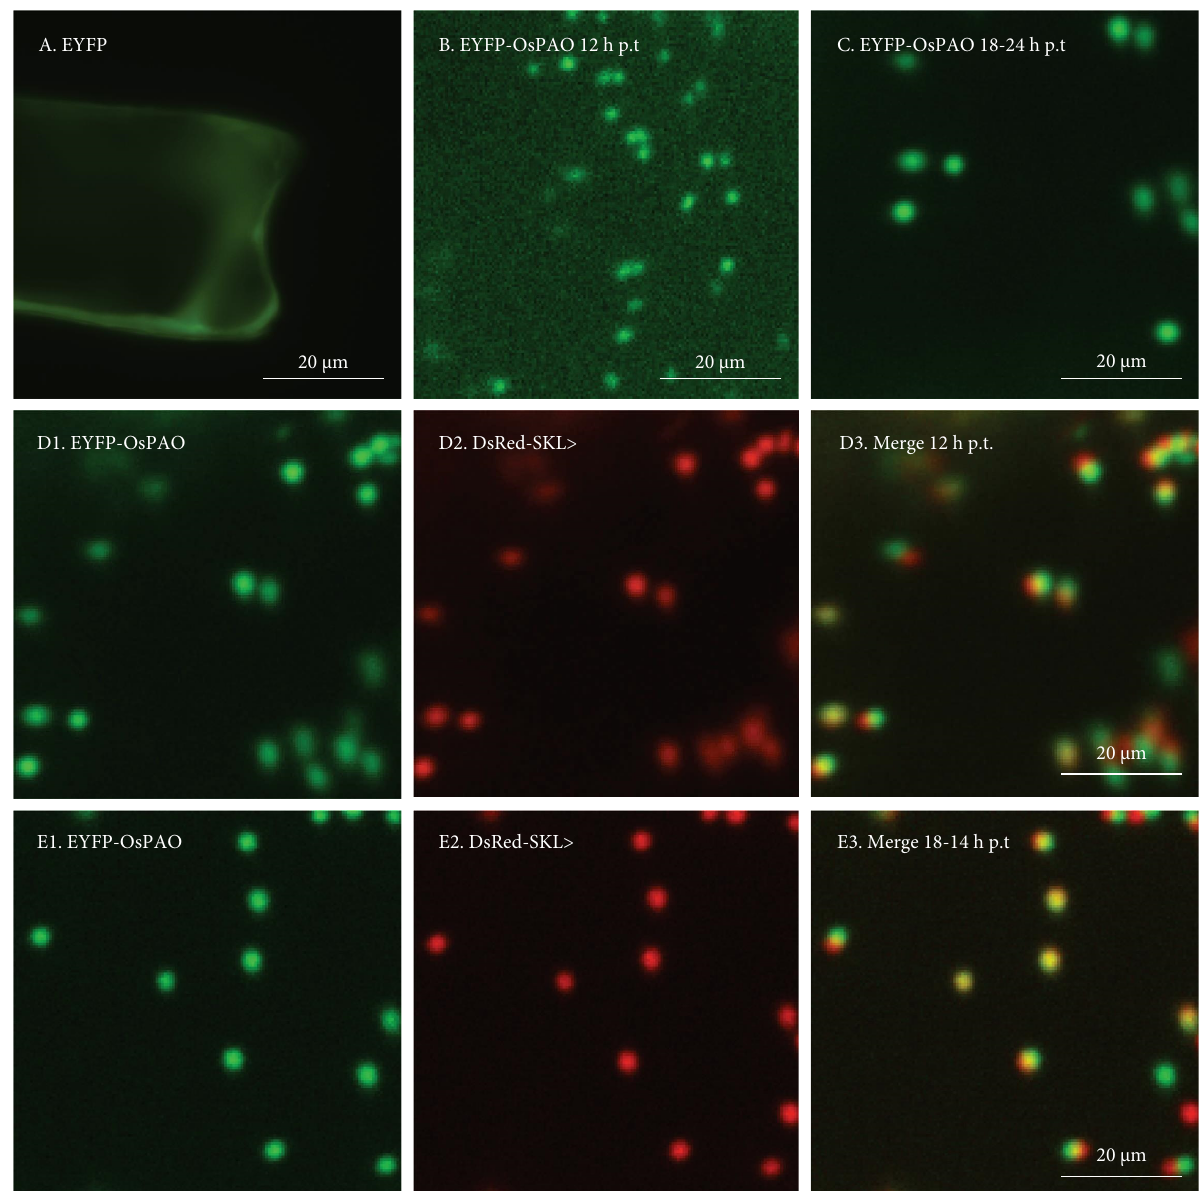
Figure 1: Subcellular localization of OsPAO3. Te OsPAO3 was cloned in the plant transient expression vector pCAT as an EYFP fusion construct. DsRed SKL was used as a peroxisome marker. Te plasmids of interest were coated with gold particles followed by biolistic bombardment of onion epidermal cells. Te onion epidermal cells were incubated at room temperature followed by analysis using fuorescence microscopy. (a) Te cytosolic EYFP fuorescence. (b, c) Te EYFP fuorescence localized in punctate structure after 12 and 18h p.t., which were confrmed to be peroxisomes upon colocalization with peroxisomal marker DsRed-SKL. (d, e) Imaging 12h and 18–24h p.t.,